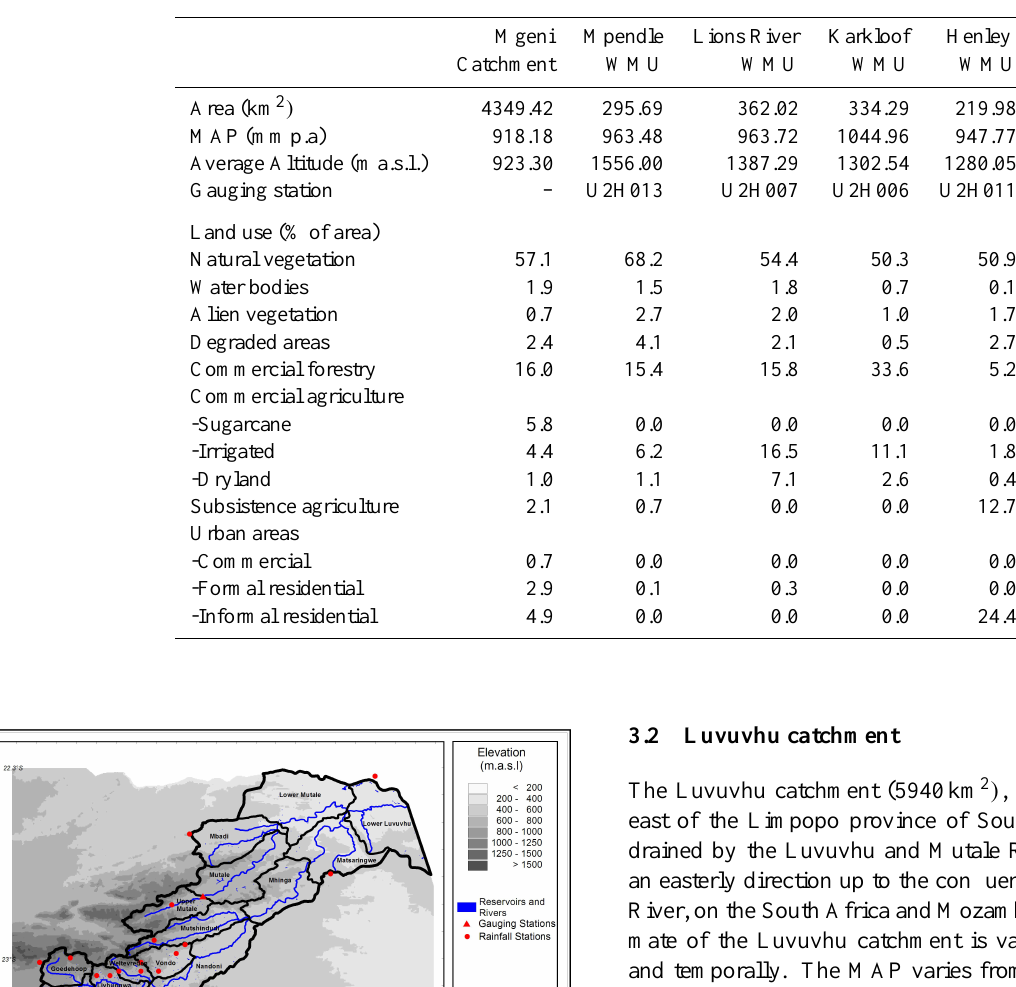
Table 2. Summary of selected features and land uses of the Mgeni Catchment and the WMUs selected for the confirmation studies.